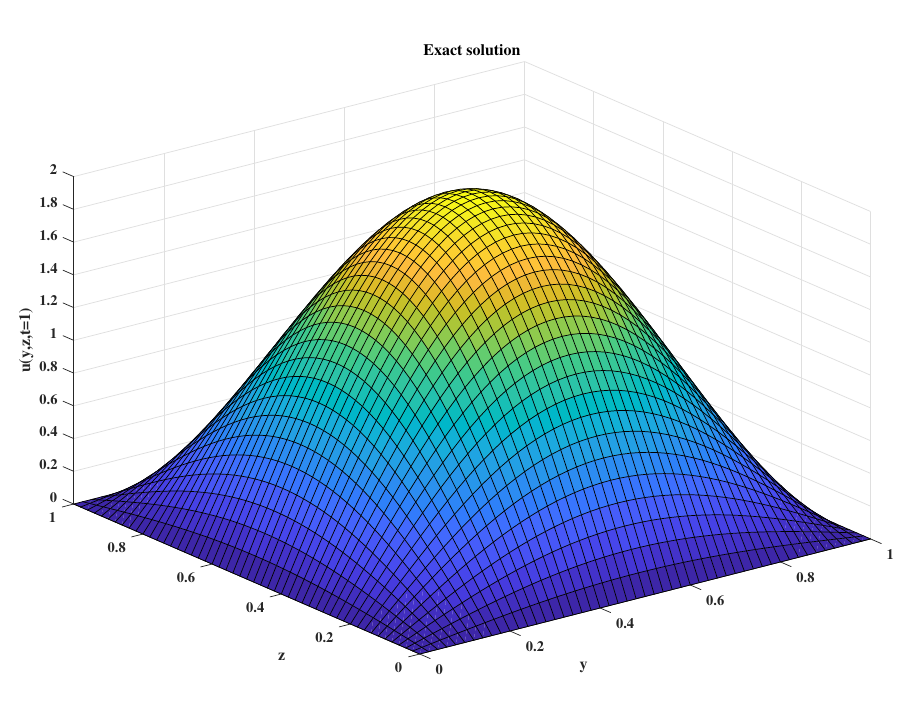
Figure 10. Exact solution of velocity distribution. Several fixed lines for comparing are selected, z = 0.3, 0.4, 0.5. Figure 11 presents the velocity distribution with y. By comparison, we can find that the numerical solution fits well with the analytical solution.